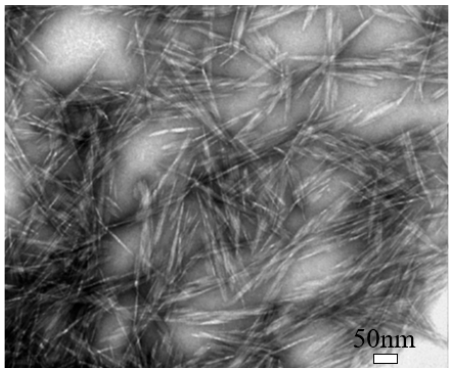
Figure 2. Transmission electron microscopy (TEM) image of cellulose nanocrystal (CNC). Reproduced (adapted) from [38], with permission from American Chemical Society, 2013.